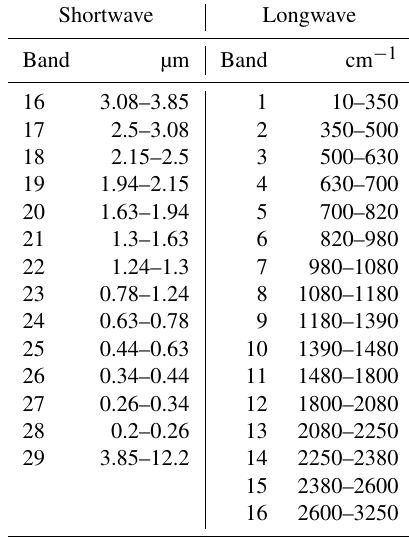
Table 1. Shortwave and longwave bands set in the RRTMG.